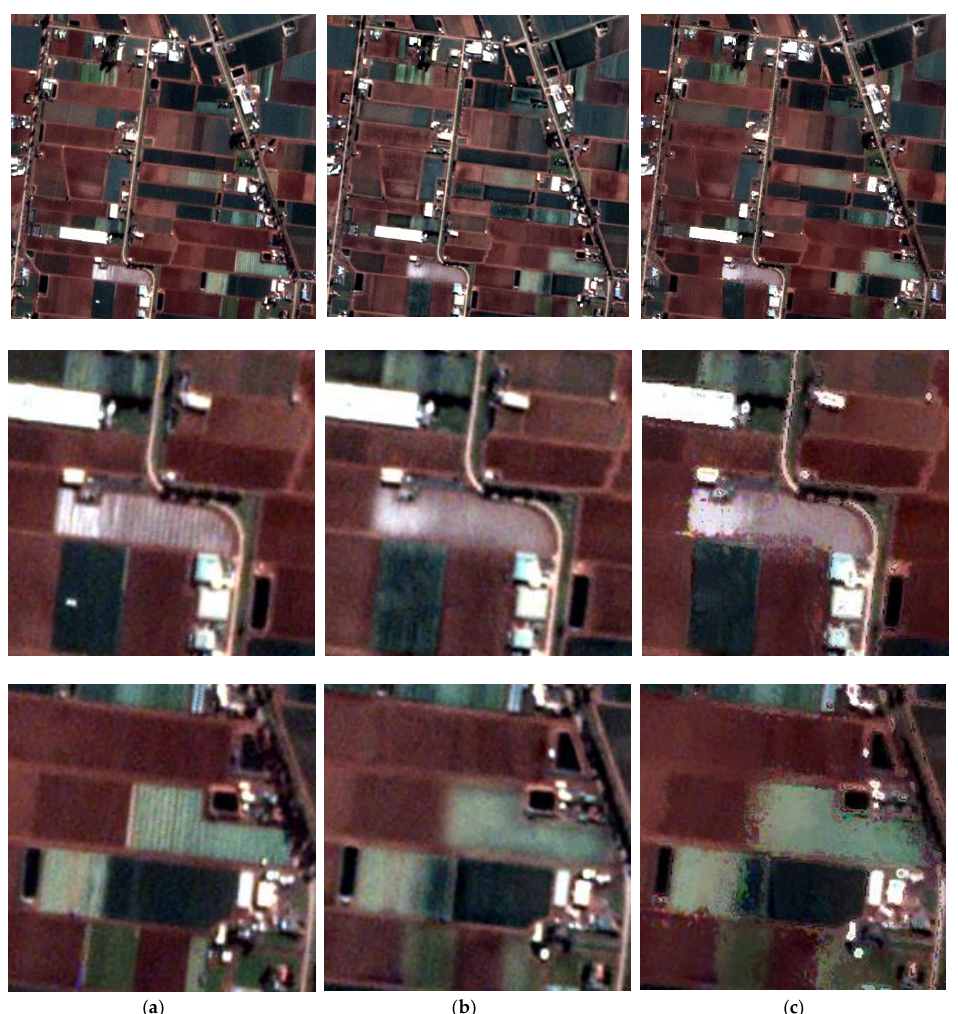
Figure 9. Fusion results for Werribee South on 31 May, 2018, zoomed to two changing fields (images in the 2nd row and the 3rd row). ( a ) PlanetScope at 3 m; ( b ) fused image at 3 m by HNN-SPOT; ( c ) fused image at 3 m by STARFM.